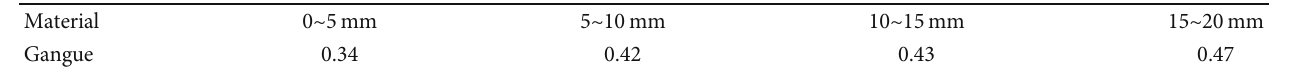
Table 4: Initial porosities of di ff erent sizes of